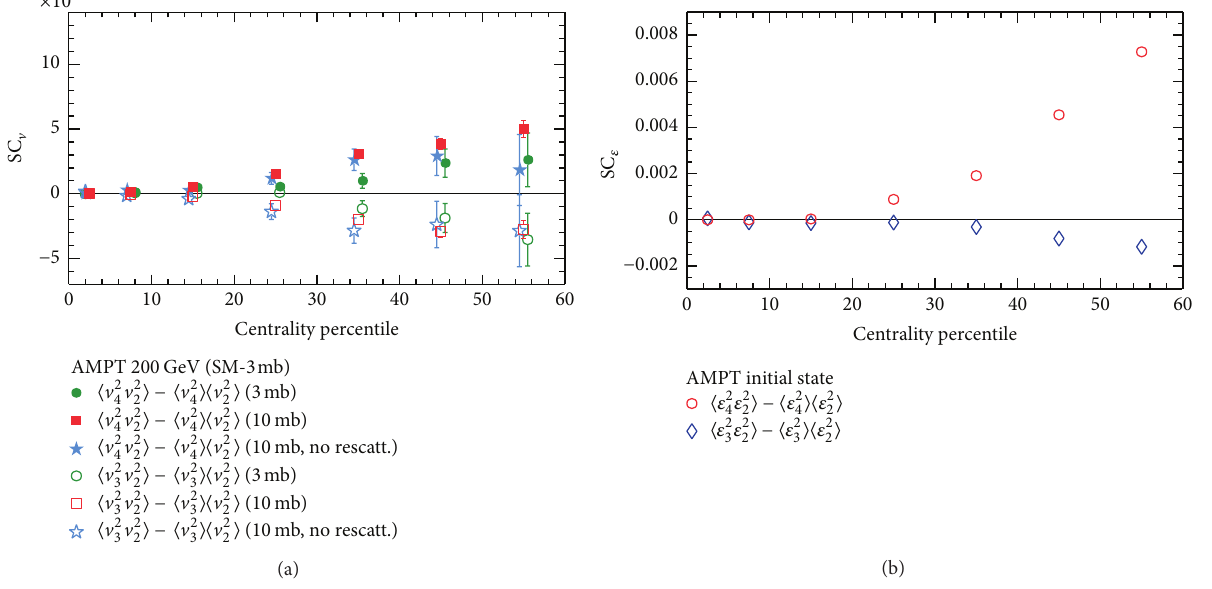
Figure 5: The centrality dependence of symmetric cumulants SC (4,2) and SC (3,2) at √𝑠 NN . Figures are taken from [72, 93].